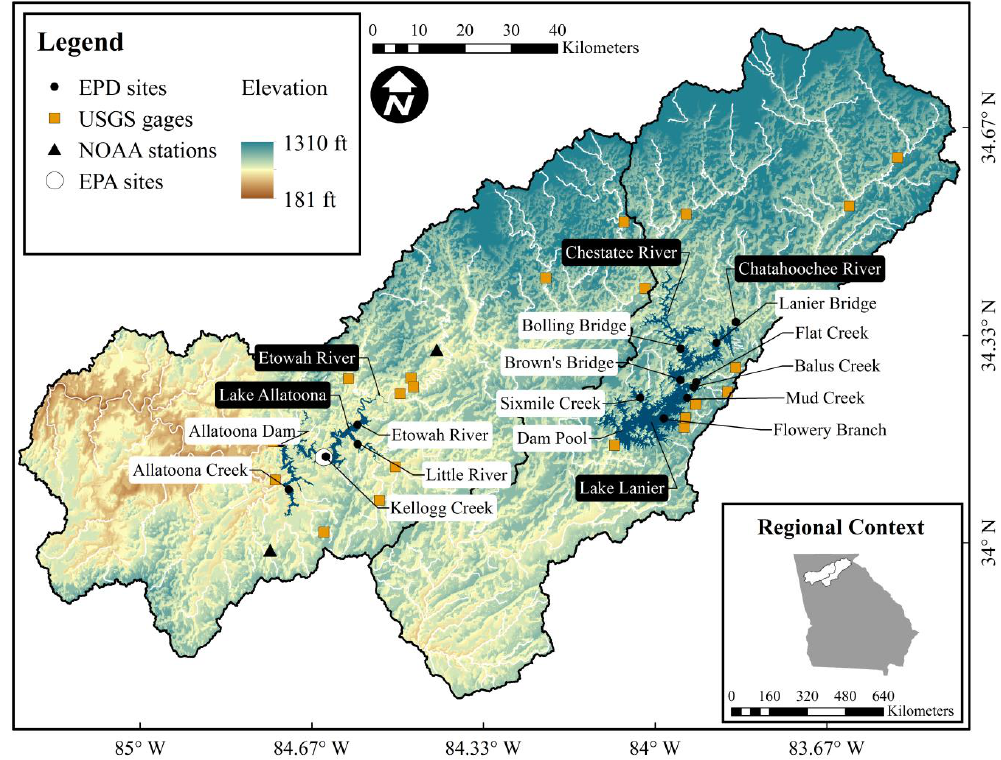
Figure 2. Study location showing data sources and sites in the Etowah and Chattahoochee River Watersheds. Five sites within the Allatoona reservoir and nine sites in the Lanier reservoir were analyzed for spatiotemporal relationships between hydrologic drivers and chlorophyll-a, a proxy for algal blooms.